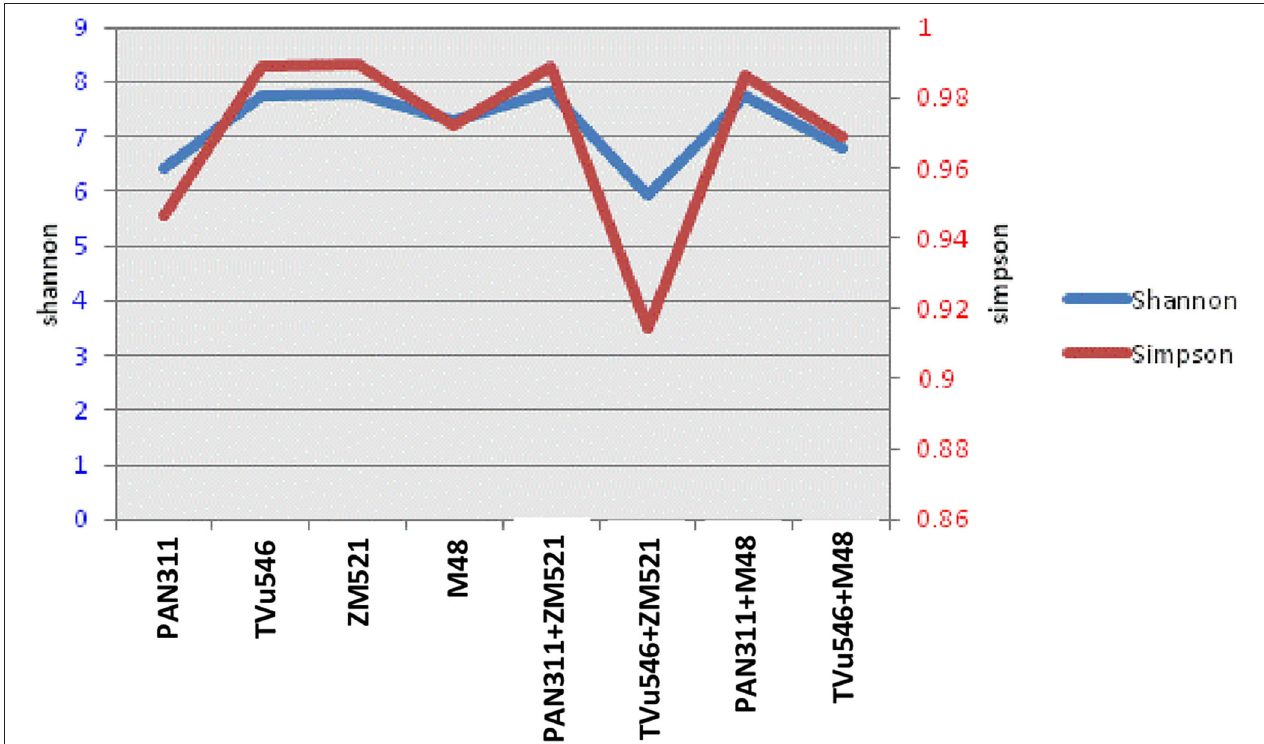
FIGURE 4 | Shannon/Simpson microbial community diversity index of test rhizosphere soil samples.